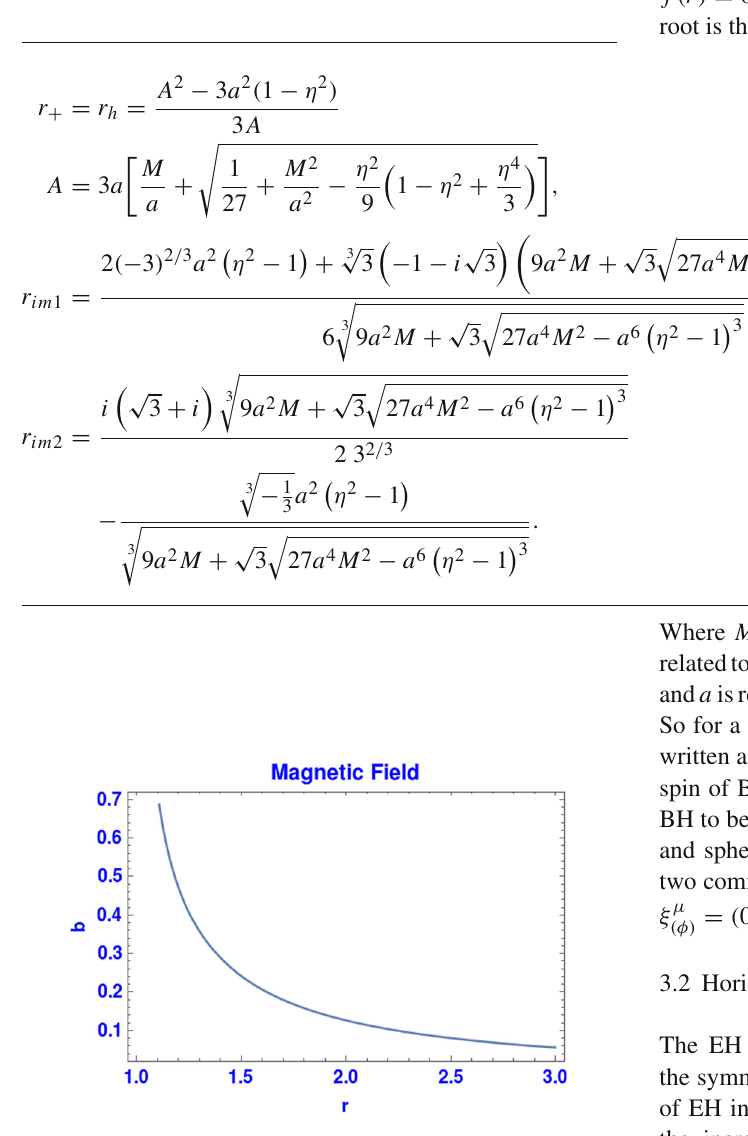
Fig. 1 Thisplotshowstrendofthemagneticfield(b)inthesurrounding ofweaklymagnetizedBH.Itisplottedfor η = 10 − 6 and a = 0 . 5.These values are followed from the BH metric given by Eq.